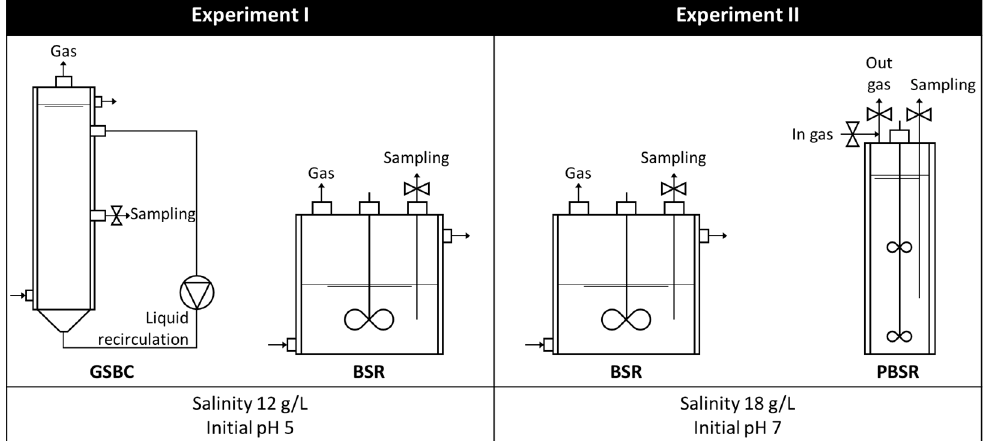
Figure 1. Schematic diagram of the experimental setup and conditions applied in experiments I and II.